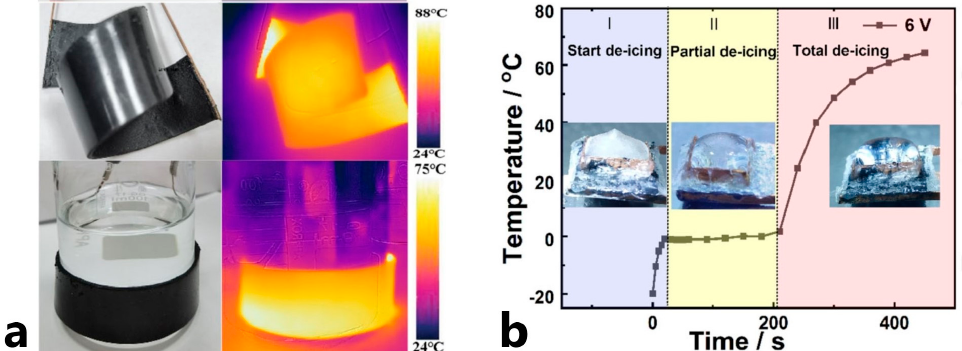
Figure 9. ( a ) Photography of fl exible FRPC, ( b ) time-dependent temperature pro fi les of the FRPC at 6 V (Reprinted with permission from Springer Nature, copyright 2021) [64].